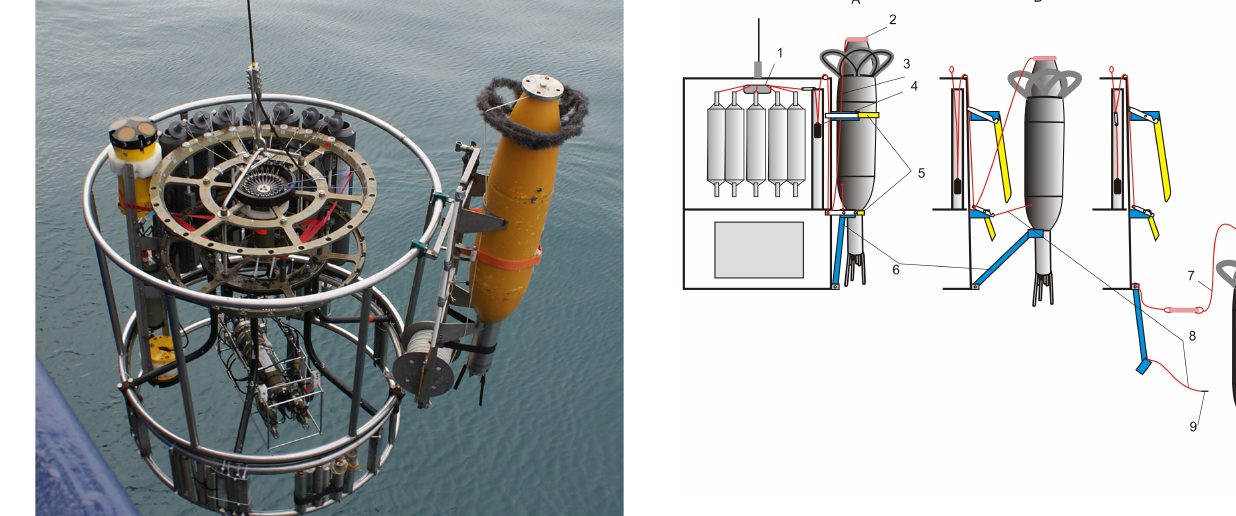
Fig. 2. Principle of releasing the MSP from the rack at a chosen depth. 1 – the trigger assembly on the Rosette rack, 2 – attached load for accelerating the MSP (needed due to the small negative buoyancy of the MSP), 3 – rope fastening the acceleration load to the rack, 4 – trigger, 5 – belts holding the MSP to the rack before release, 6 – turning support, which prevents the MSP from hitting the rack when released, 7 – the main tether, 8 – release cord for the magnet, 9 – magnet, which switches the MSP recording on. (A) shows the configuration before releasing the MSP; in this config- uration the MSP is tightly fastened to the rack by two belts; (B) shows the beginning of the release as belts are unlocked by drop- ping a load, and the MSP moves down and aside due to the joint action of the accelerating load and the turning support; (C) shows the beginning of the free fall as the magnet is pulled out and the MSP recording